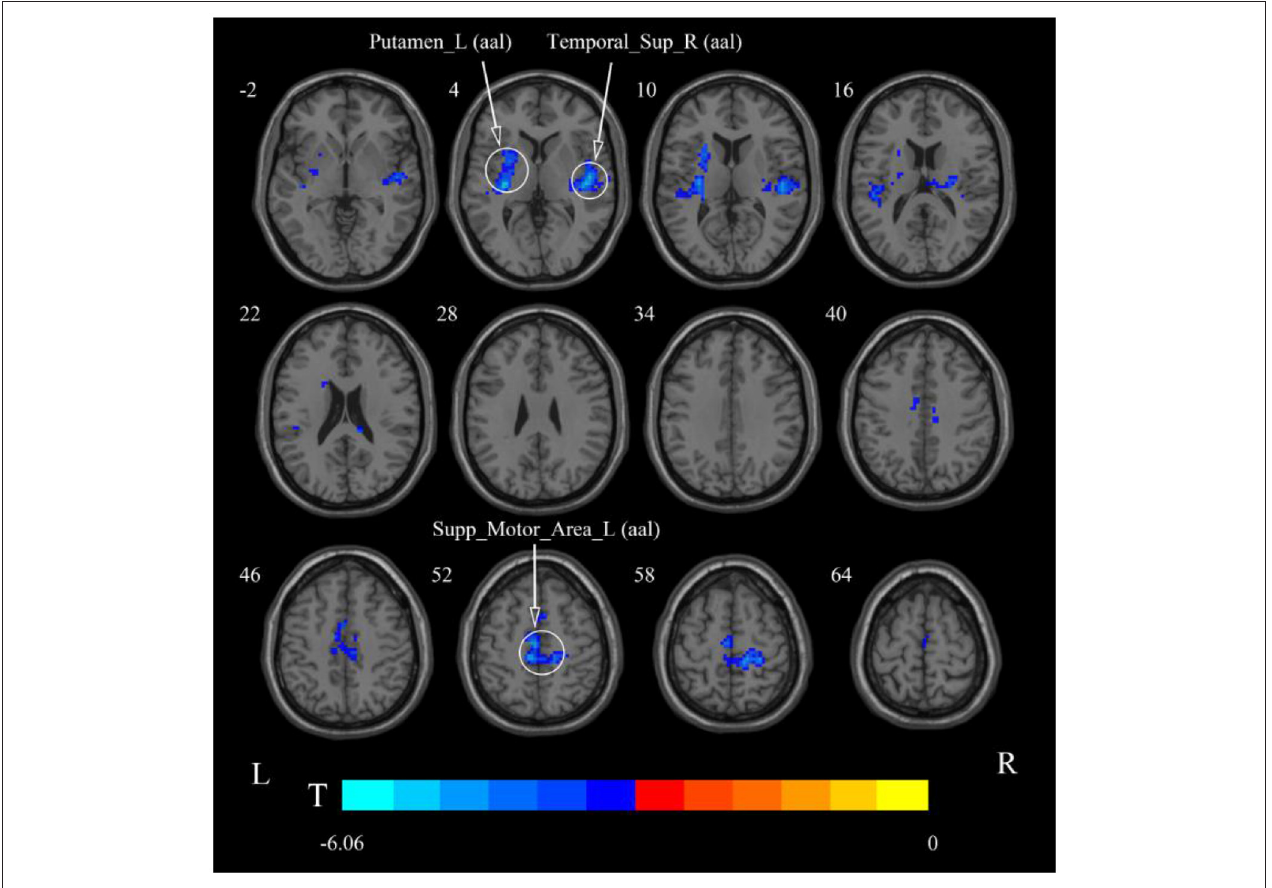
FIGURE 8 | Statistical maps showing ReHo change pre- and post-rTMS in the slow-5 band. Cool colors showing ReHo decreased after rTMS p <